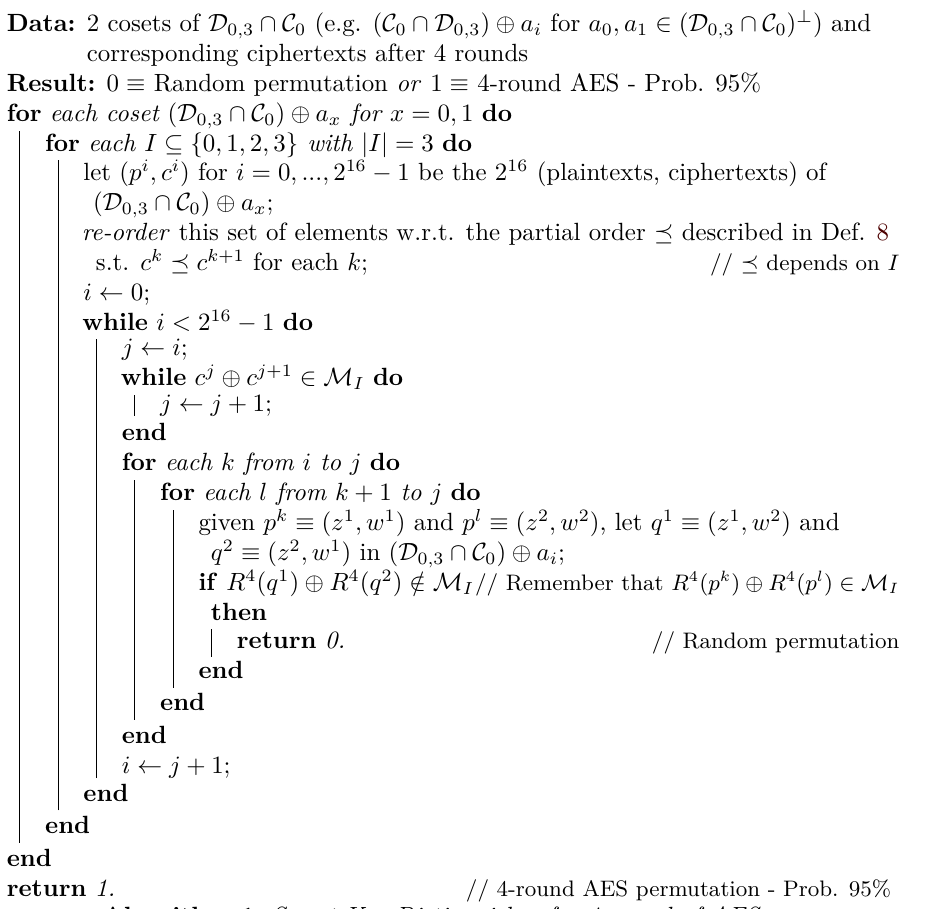
Algorithm 1: Secret-Key Distinguisher for 4-round of